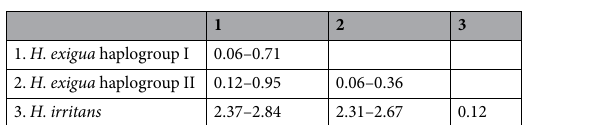
Table 3. Intra-and inter-specific uncorrected p genetic distances (%) among three taxa of Haematobia flies.